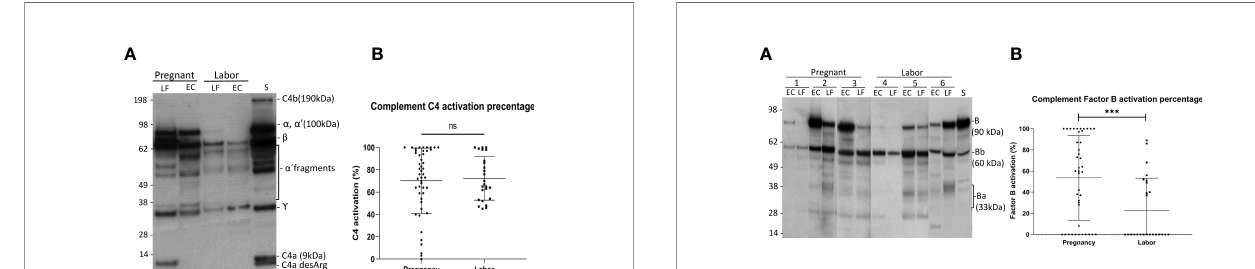
FIGURE 2 | Activation of the complement classical pathway analyzed by C4 cleavage in the vaginal mucosa during pregnancy and labor. (A) shows the cleavage pattern of C4 in the vaginal samples, as well as in normal human serum (S) as a reference. The cleavage was studied by running the samples in SDS-PAGE under reducing conditions and using Western blotting with polyclonal anti-C4 antibody for detection of C4 polypeptides and their cleavage fragments. Analyses from two patients are shown: one was sampled in late pregnancy (group A1) and the other during active labor (group A2). Two samples were analyzed per patient: one from the lateral fornix (LF) and the other from external cervix (EC), no signi fi cant difference was noted between the sample sites. (B) represents calculated percentages of C4 activation in EC samples collected during pregnancy vs during labor. The level of C4 activation was determined by assessment of the amount of C4 a ´-chain and its cleavage fragments relative to the total amount of C4 a -chain with its fragments. Strong activation of C4 is detected, but there is no signi fi cant difference between the